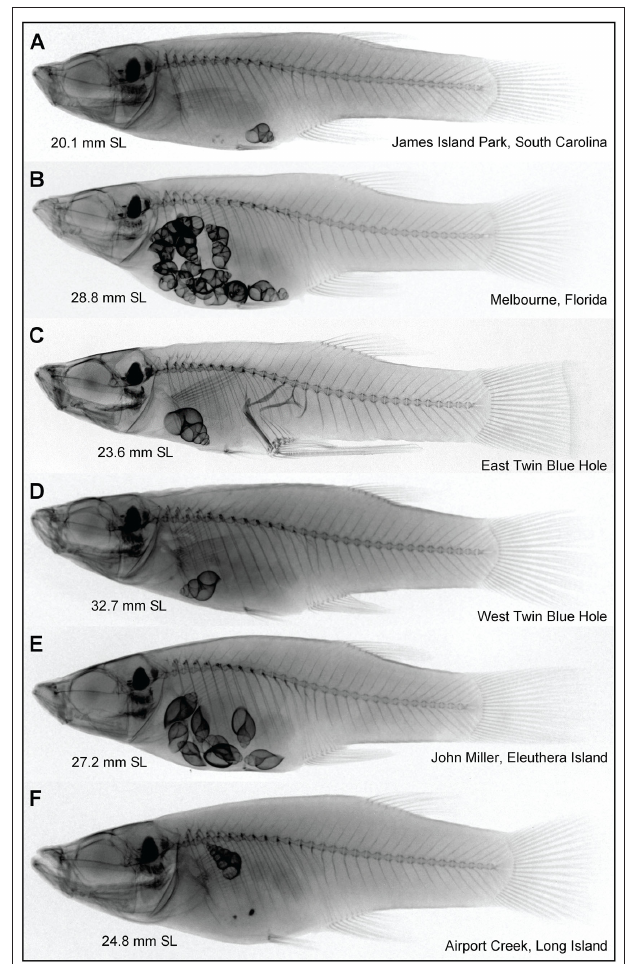
FIGURE 3 | Representative x-ray images of wild-caught (A,B) Gambusia holbrooki , (C,D) Gambusia hubbsi , and (E,F) Gambusia manni that had consumed snails (standard length of each fish